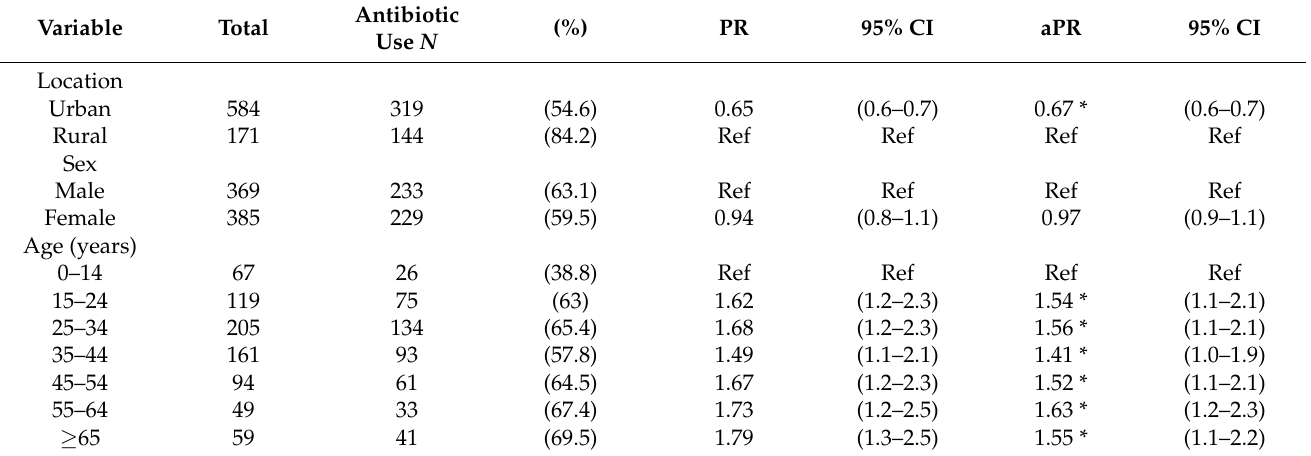
Table 5. Prevalence of antibiotic use and its associated factors among people with suspected